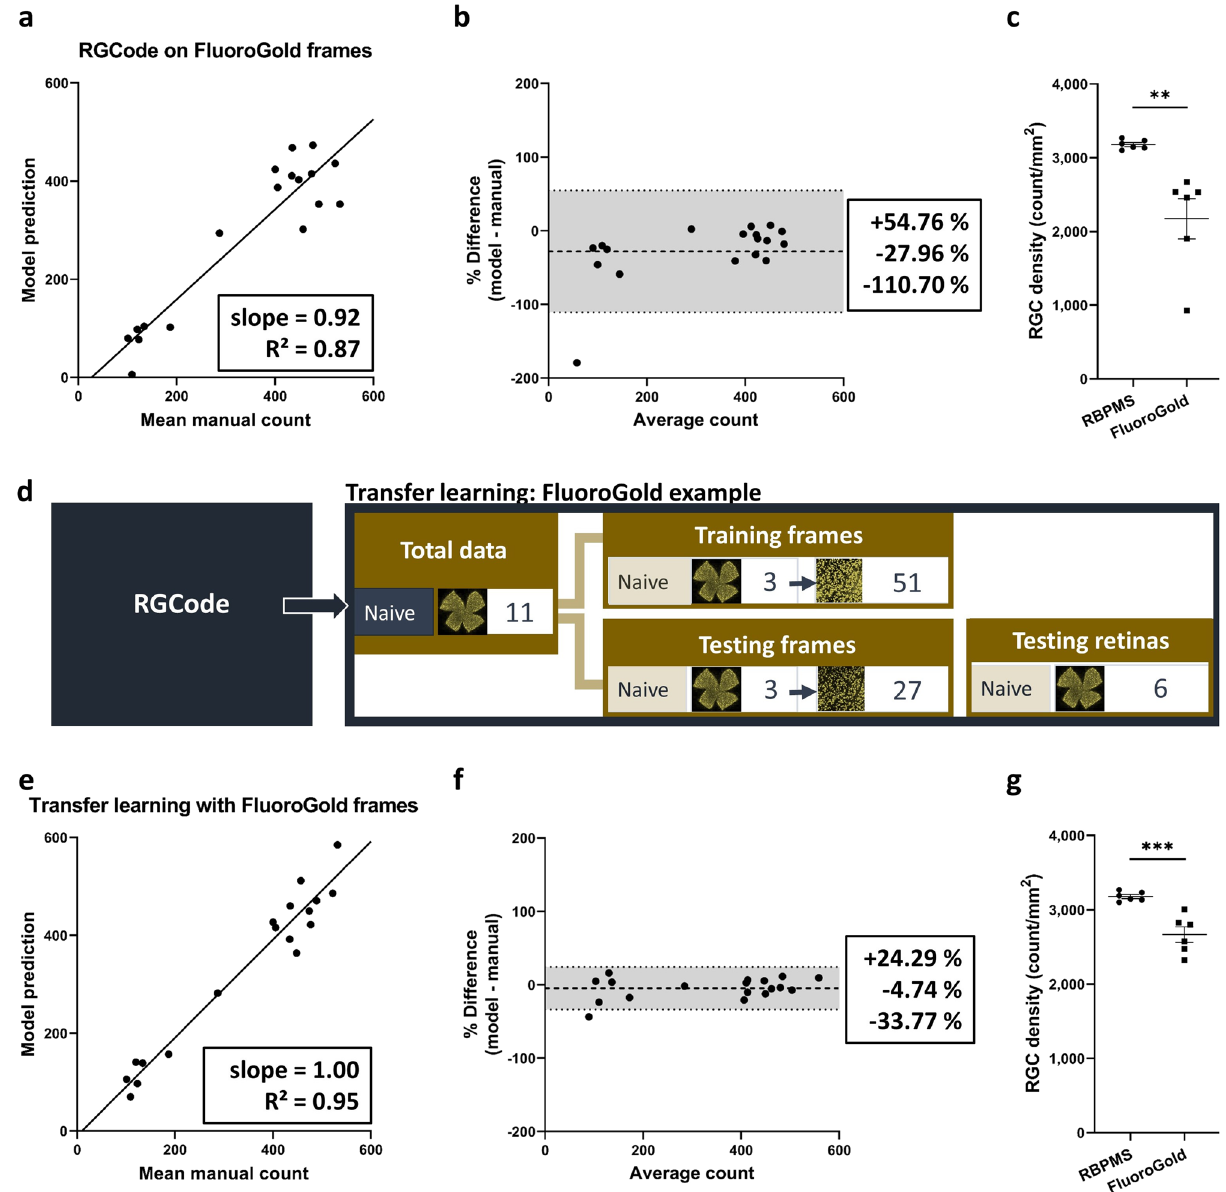
Figure 6. Transfer learning of RGCode for Fluorogold labelling. ( a , b ) Linear regression and Bland Altman analysis (mean bias ± 95% limits of agreement) after running RGCode on Fluorogold-labelled RGCs. Counting performance was considerably lower as compared to the RBPMS dataset, whereas a higher bias was observed. ( c ) the lower performance of RGCode on FluoroGold-traced flatmounts resulted in a high variability in density (mean ± SEM, unpaired, two-tailed t test, ** p = 0.0042; *** p = 0.0007). ( d ) Composition of the training and testing dataset used for transfer learning. ( e , f ) Transfer learning of RGCode with a minimal set of new